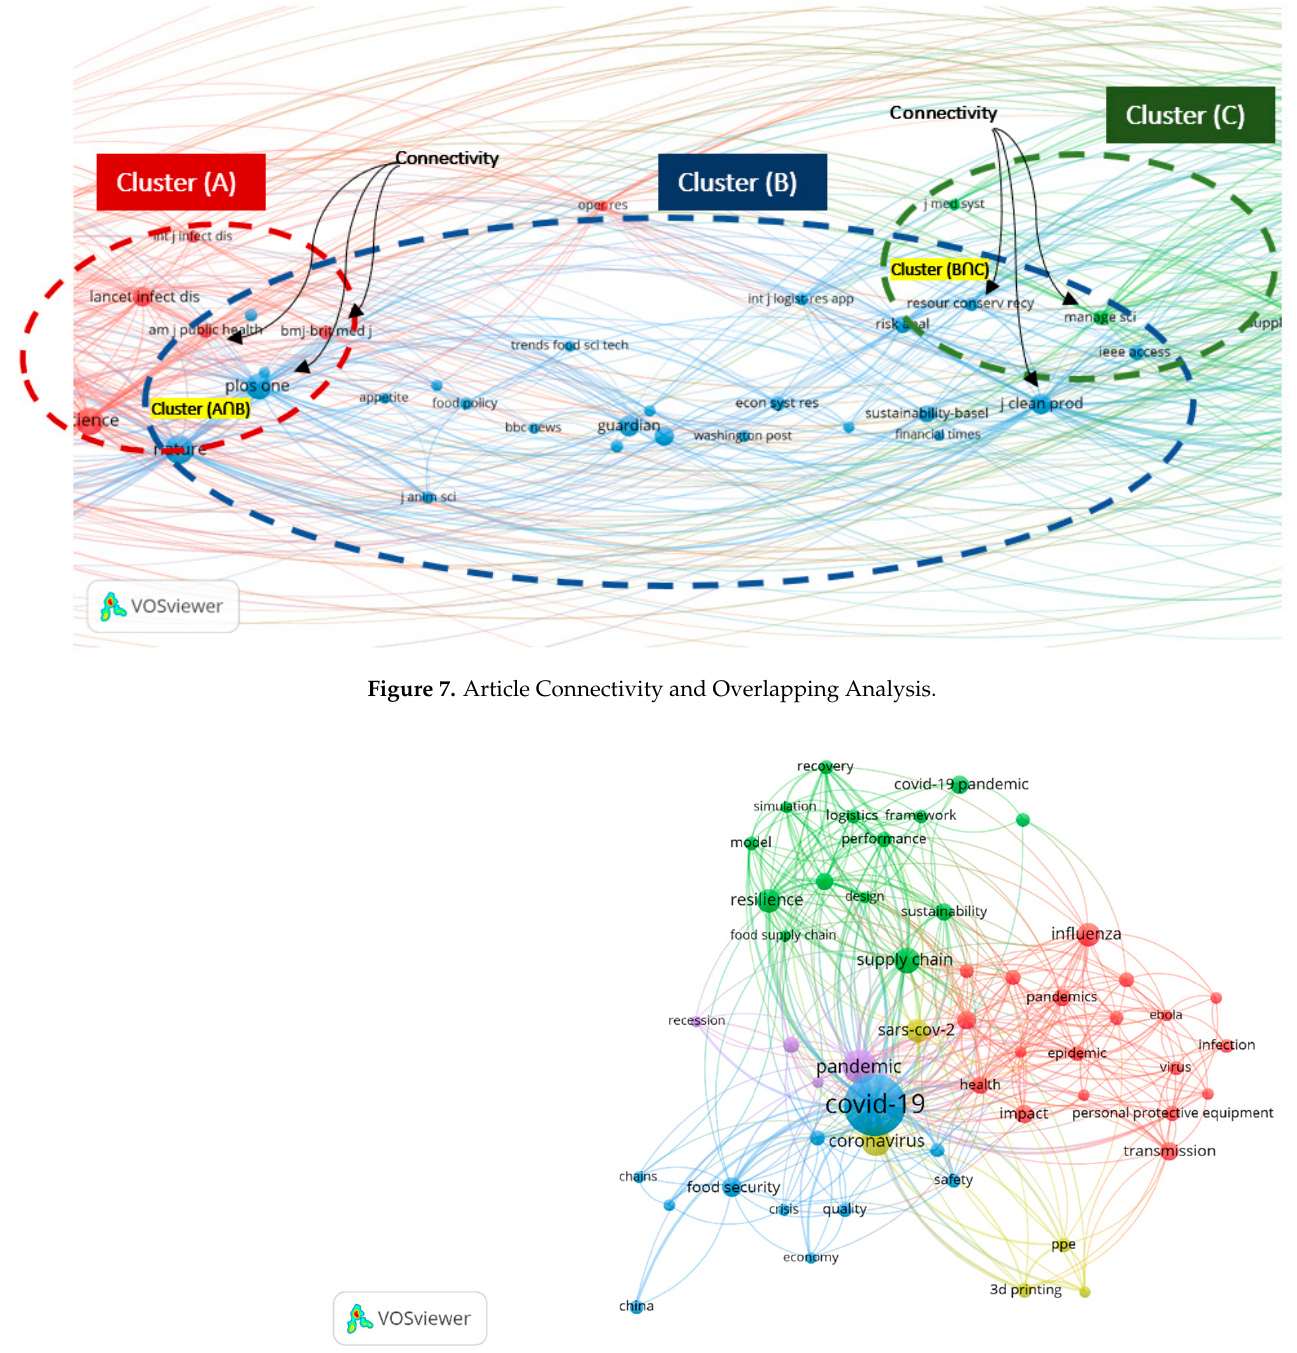
Figure 8. Article Network Through Clustering Analysis (source: VOSviewer).